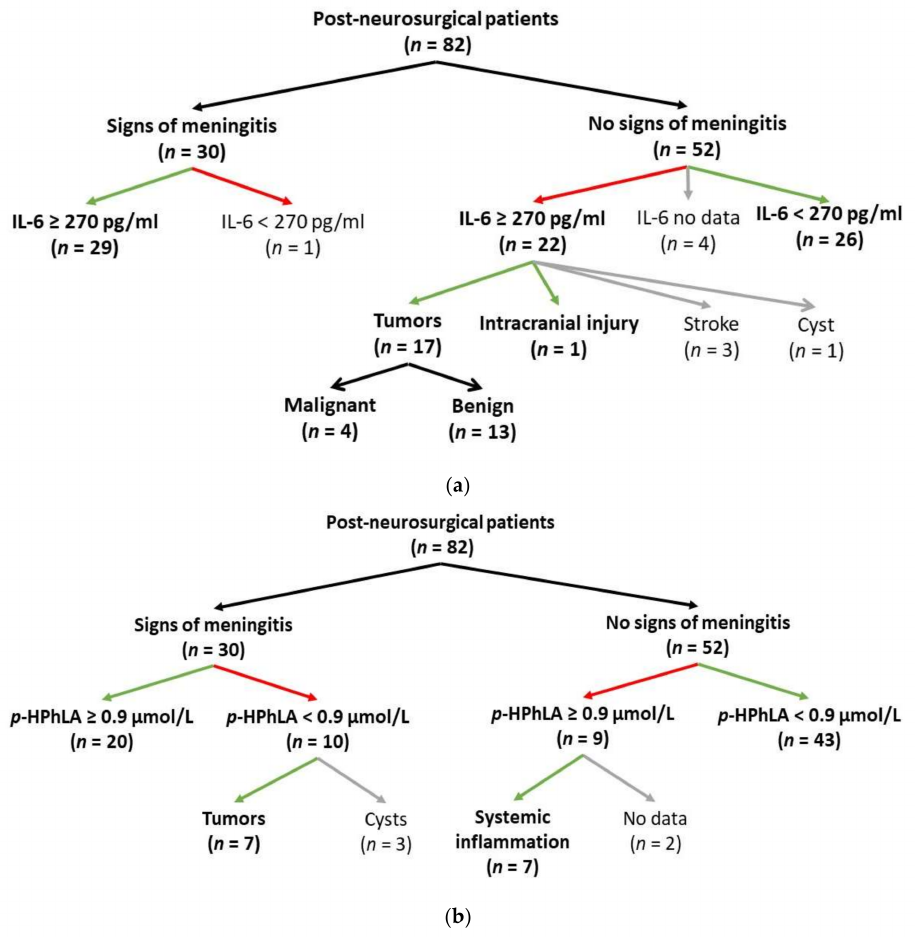
Figure 1. The CSF levels of IL-6 ( a ) and p -HPhLA ( b ) in patients with ( n = 30) and without ( n = 52) signs of post-neurosurgical meningitis. Table 3. The ROC analysis results for the p -HPhLA and IL-6 levels in CSF as the predictors of post-neurosurgical meningitis (CNS inflammation) and for the p -HPhLA in CSF as the predictor of systemic inflammation (in